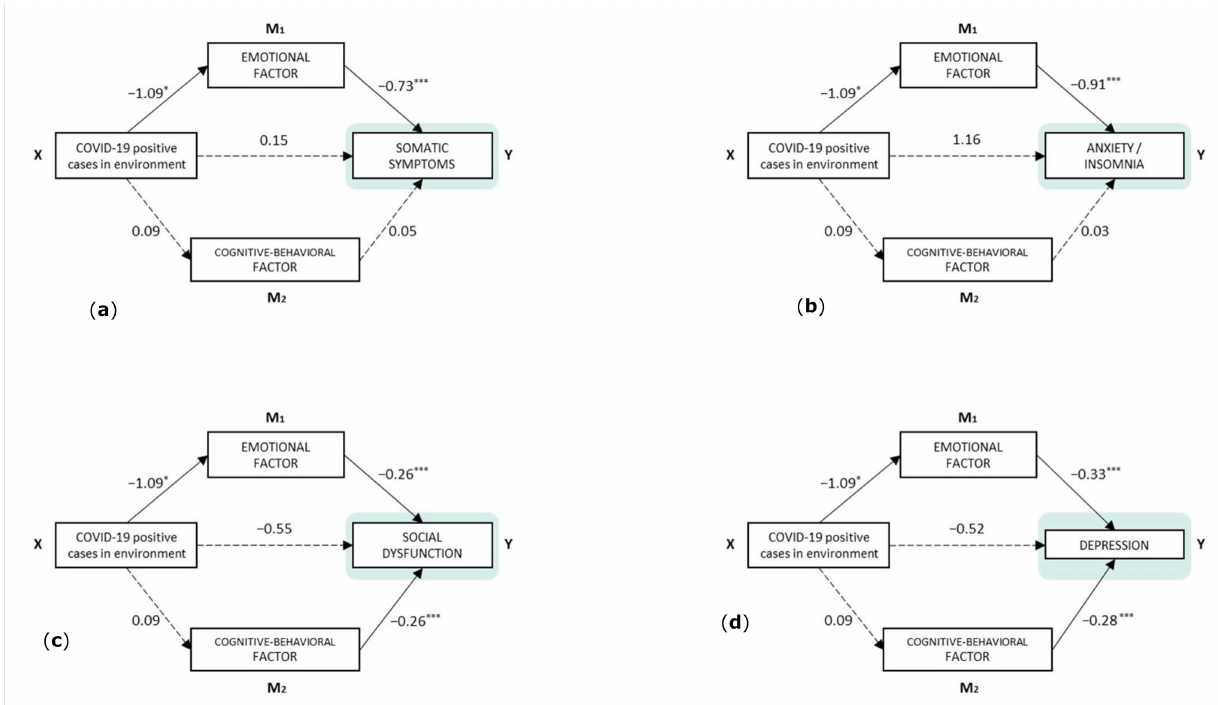
Figure 2. Components of direct effects and model paths. ( a ) Y = Somatic symptoms, ( b ) Y = Anxiety/insomnia, ( c ) Y = Social dysfunction, ( d ) Y = Depression. Note. * p < 0.05,